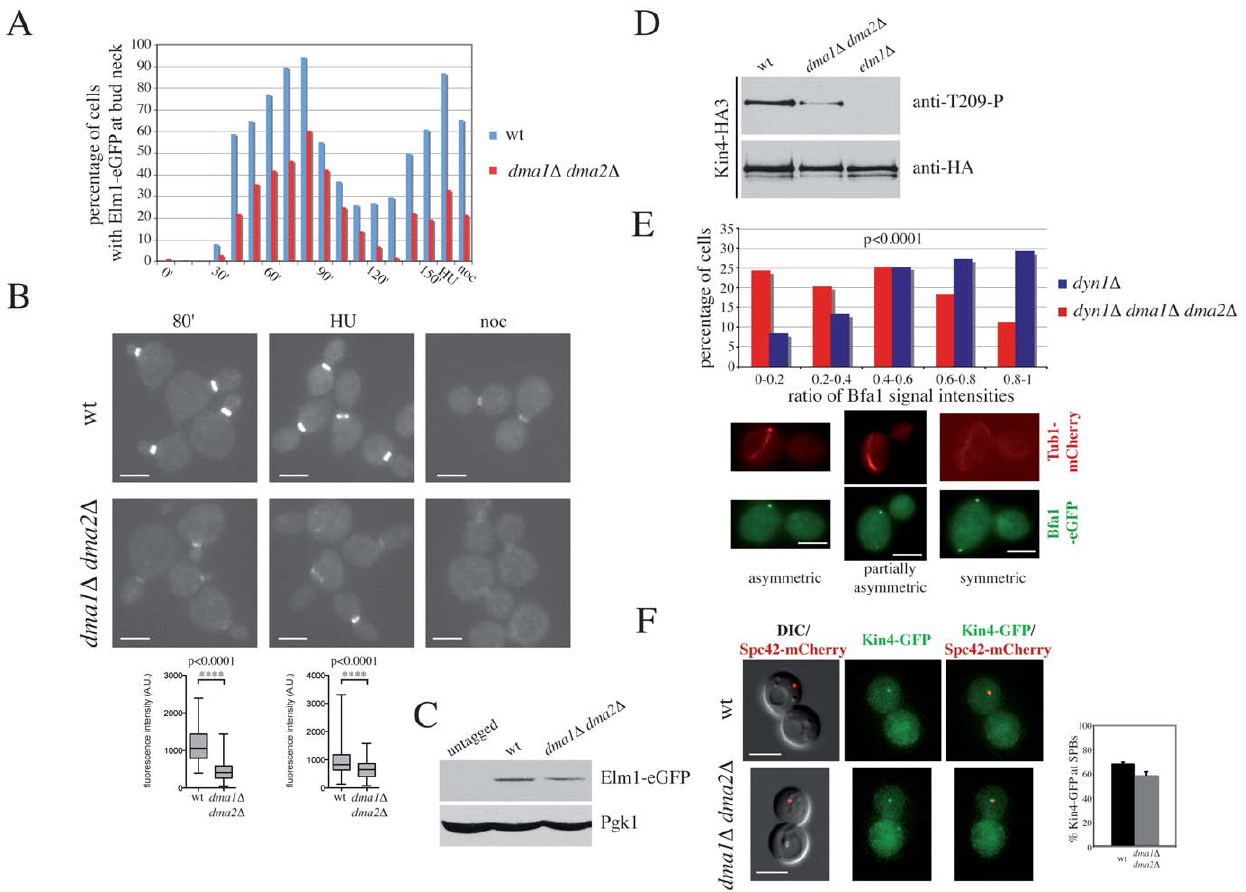
Figure 6. Dma proteins control Elm1 recruitment to the bud neck and Kin4 activation. A, B: Wild type (ySP8813) and dma1 D dma2 D (ySP8829) cells expressing Elm1-eGFP were arrested in G1 by alpha factor and released into the cell cycle at 25 u C (time 0). The culture was split in three parts: one part was left untreated, while the other two were incubated for 150 minutes with HU (120 mM) and nocodazole (15 m g/ml), respectively. Cell samples from the untreated culture were withdrawn at the indicated times for FACS analysis of DNA contents (Figure S6A) and to score budding, nuclear division and bud neck localization of Elm1-eGFP (A and Figure S6B). Representative micrographs were taken for all cultures (B). Fluorescence intensity was quantified in 100 cells for each strain at time 80 9 for untreated cells and 150 9 for HU-treated cells, and values were plotted in the bottom graphs. Scale bars: 5 m m. C: Western blot with anti-GFP antibodies of cell extracts from untagged cells or wild type (ySP8813) and dma1 D dma2 D (ySP8829) cells expressing Elm1-eGFP. Pgk1: loading control. D: HA-tagged Kin4 (Kin4-HA3) was immunoprecipitated with anti-HA beads from extracts derived from cycling cultures of wild type (ySP8986), dma1 D dma2 D (ySP8987) and elm1 D (ySP8997) cells. Immunoprecipitates were subjected to western blot analysis with anti-T209-P [38] and anti-HA antibodies. E: dyn1 D (ySP9493) and dyn1 D dma1 D dma2 D (ySP9492) cells expressing Bfa1-eGFP and Tub1-mCherry were grown at 25 u C and then shifted to 14 u C for 16 hours. Fluorescence intensities of Bfa1-eGFP signals at the two poles of misaligned spindles were quantified on max projected images and plotted as ratios between the less and the most fluorescent signal (ratio=0: complete asymmetry; ratio=1: complete symmetry; n . 98). Scale bars: 5 m m. F: Wild type (ySP8995) and dma1 D dma2 D (ySP8994) cells expressing Kin4-GFP and Spc42-mCherry were arrested in mitosis with nocodazole. Z-projected images of representative cells with Kin4-GFP co- localizing with Spc42-mCherry are shown. The histograms on the right side show the quantification of data with standard error bars from three independent repeats. 150–250 cells were scored for each strain in each experiment. Scale bars: 5 m